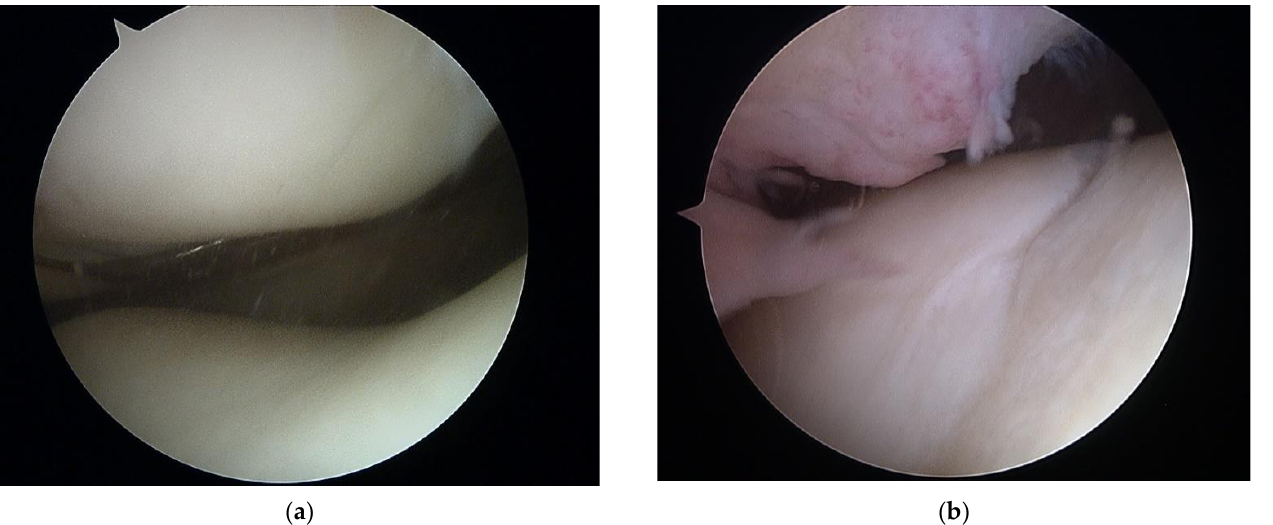
Figure 1. Arthroscopic view of patellofemoral joint with healthy cartilage ( a ) and grade III chondral lesions in the patellar groove of the femur ( b ).